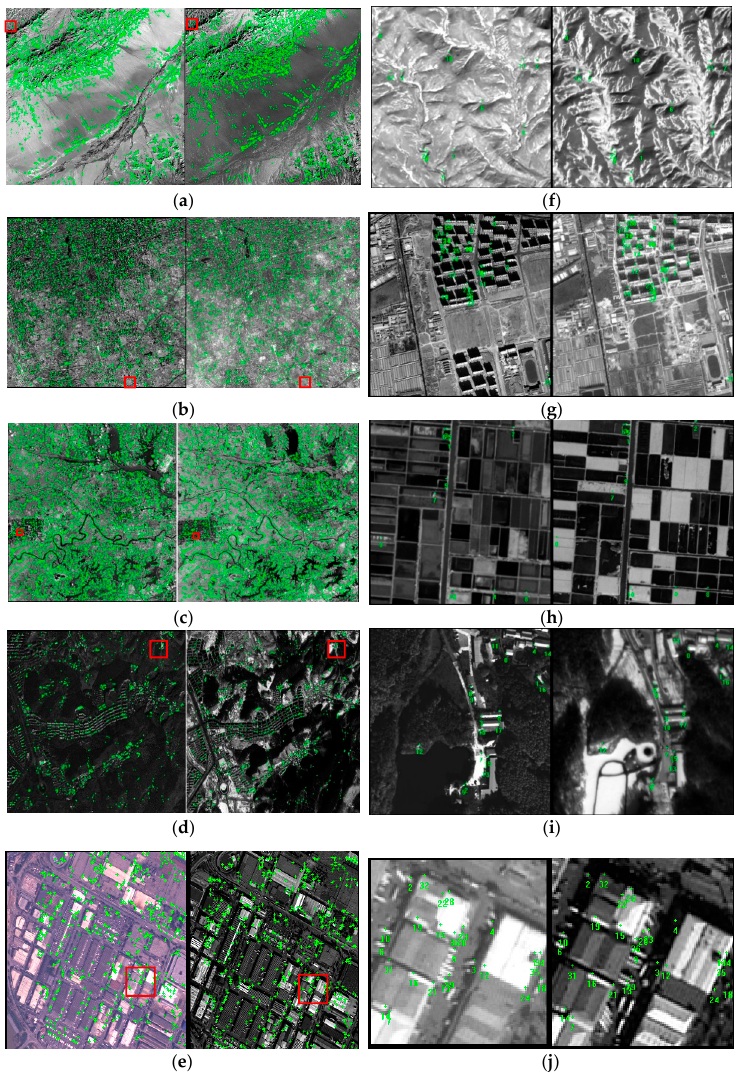
Figure 10. Matching results of ATBM. ( a – e ) showed the matching results of GF-1 and ZY-3, GF-2 and ZY-3, ZY3-BWD and ZY3-NAD, UAV and JL1, and SPOT 5 and SPOT 6 sensors, and ( f – j ) showed the matching details of the sub-images, which was marked by red rectangles in ( a – e ).